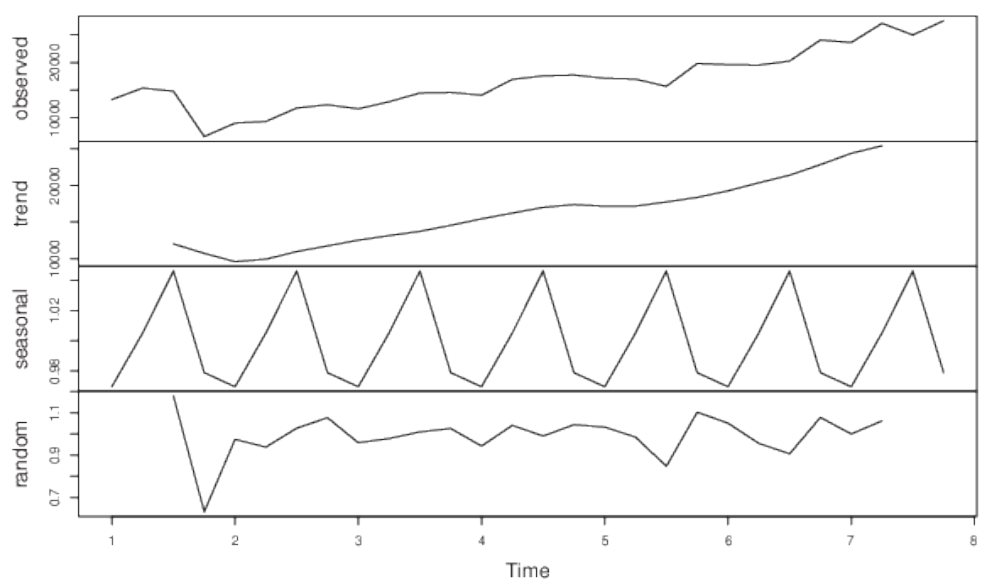
Figure 1. International liquidity ( IL_TR ) multiplicative time series